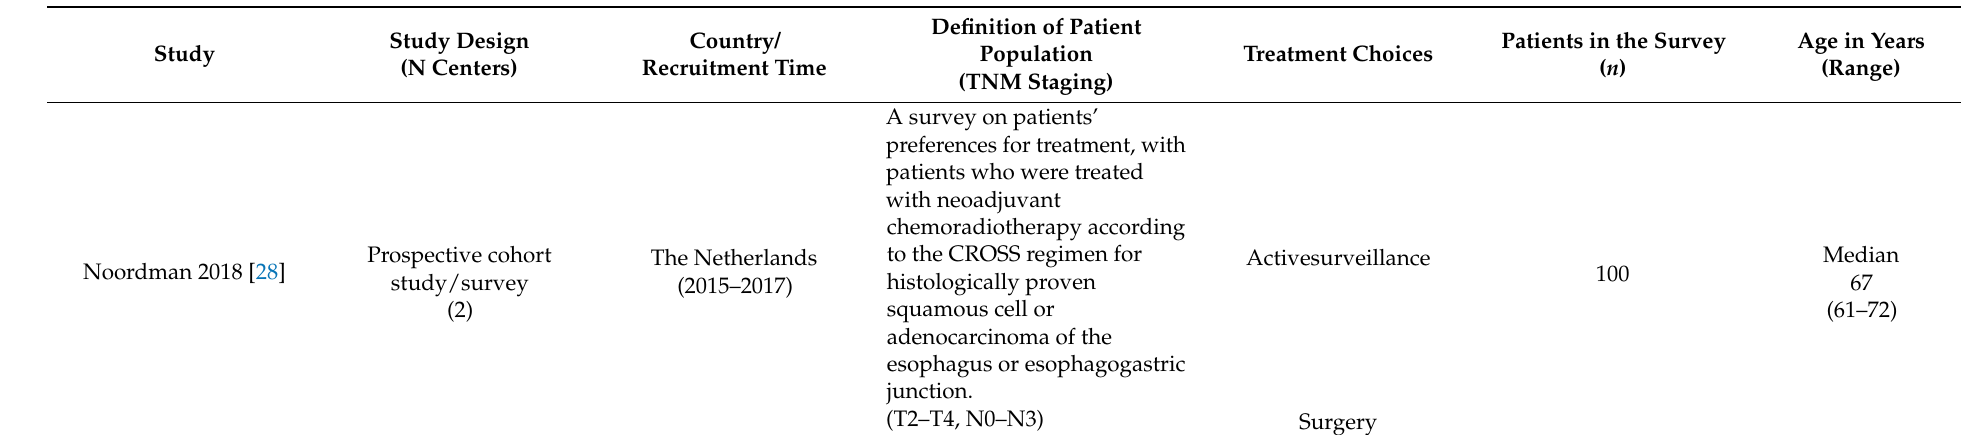
Table 3. Characteristics of the survey on patients’